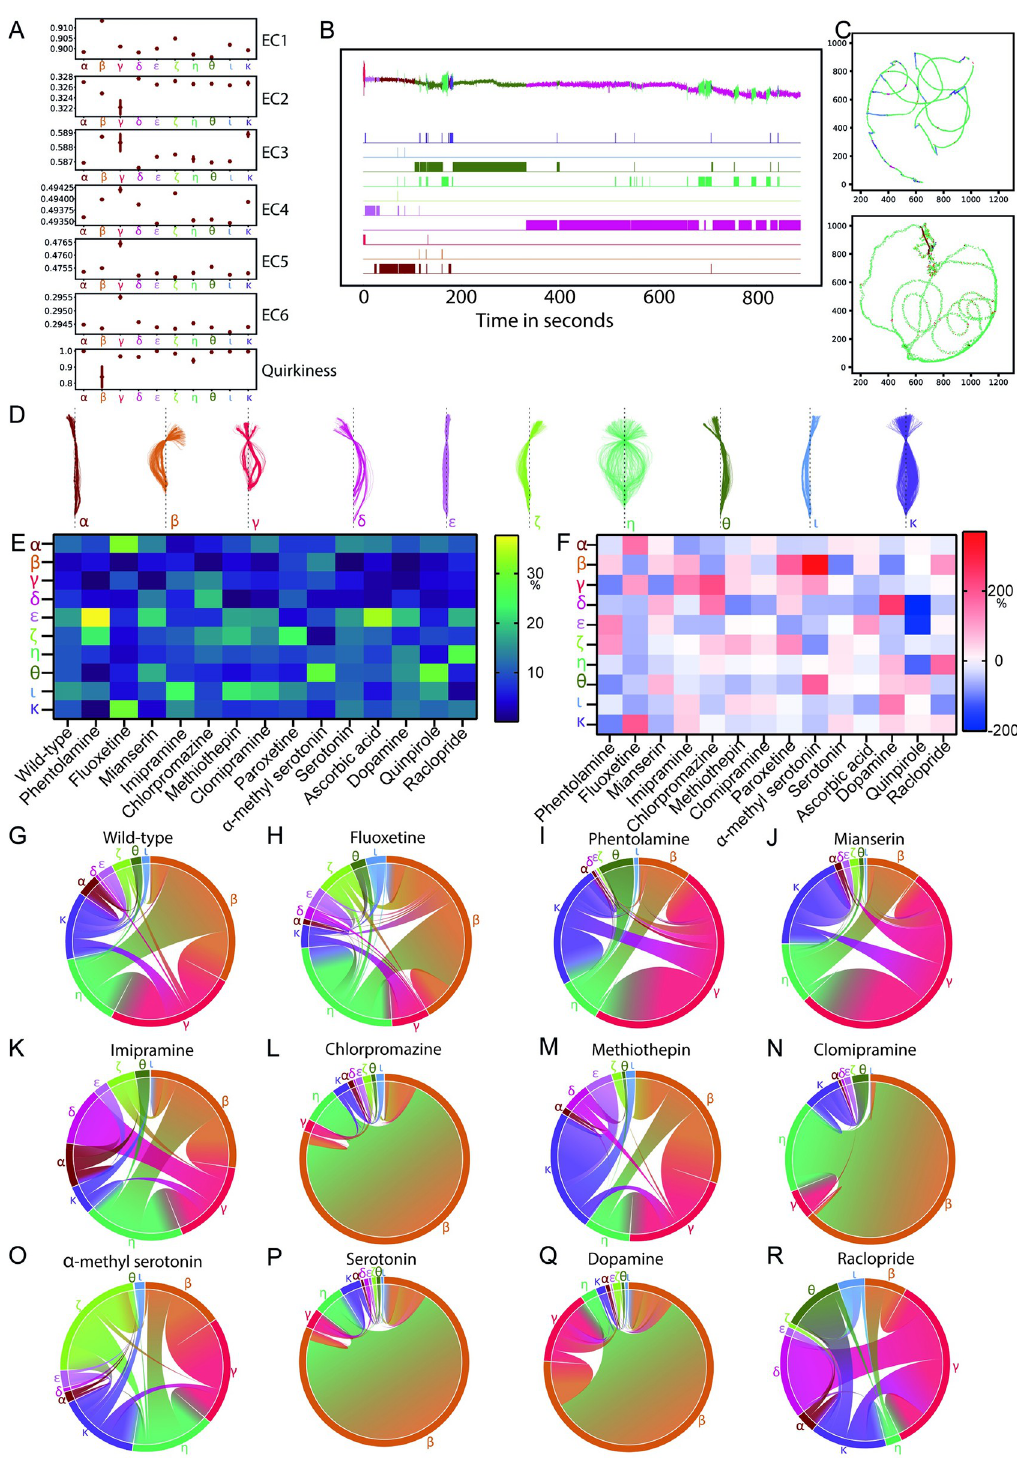
Fig 4. HMM analysis reveals that behavioral transitions in Ciona are modulated by bioamines. (A) Plots summarizing the observation probability distributions defined by the HMM model. For each of the states (horizontal axes), the mean of Gaussian distributions of each of the 7 input features is plotted along the vertical axes. The variance of the distributions is indicated by the error bars (underlying data can be found in S20–S22 Tables and https://doi.org/10.5281/zenodo.6761771). (B) HMM segments and clusters a time series into modules by identifying the underlying state for each time point in the series. On the